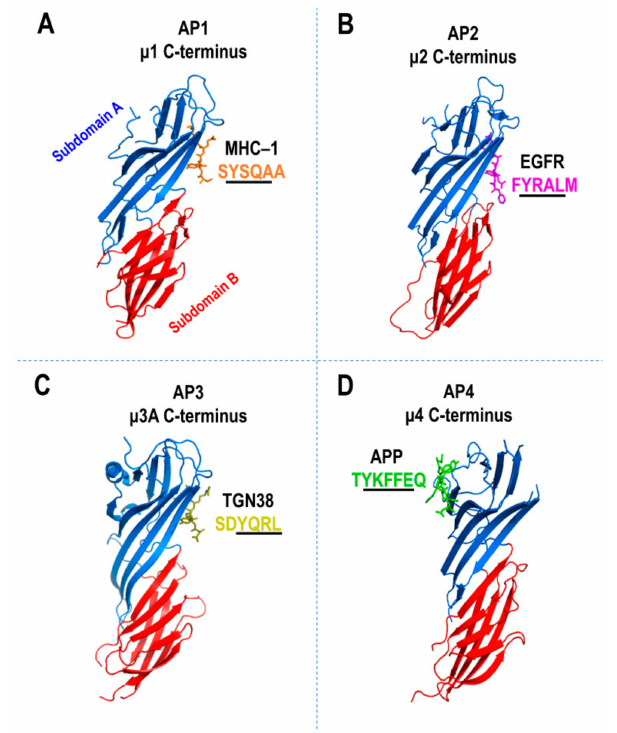
Figure 5. Tyrosine sorting motifs binding sites on AP complex. Crystal structures of the C-terminal domains of µ subunits of AP-1 through 4 in association with tyrosine-based sorting motifs (underlined). The C-terminal domains of µ 1–4 are further subdivided into subdomain A (blue) and subdomain B (red). ( A ) Mouse AP-1 µ 1 C-terminal domain in complex with class 1 major histocompatibility complex (MHC-1) peptide SYSQAA (PDB: 4EN2), ( B ) rat AP-2 µ 2 C-terminal domain in complex with epidermal growth factor receptor (EGFR) peptide FYRAL (PDB: 1BW8), ( C ) rat AP-3 µ 3A C-terminal domain in complex with TGN38 peptide SDYQRL (PDB: 4IKN), ( D ) human AP-4 µ 4 C-terminal domain in complex with amyloid precursor protein (APP) peptide TYKFFEQ (PDB: